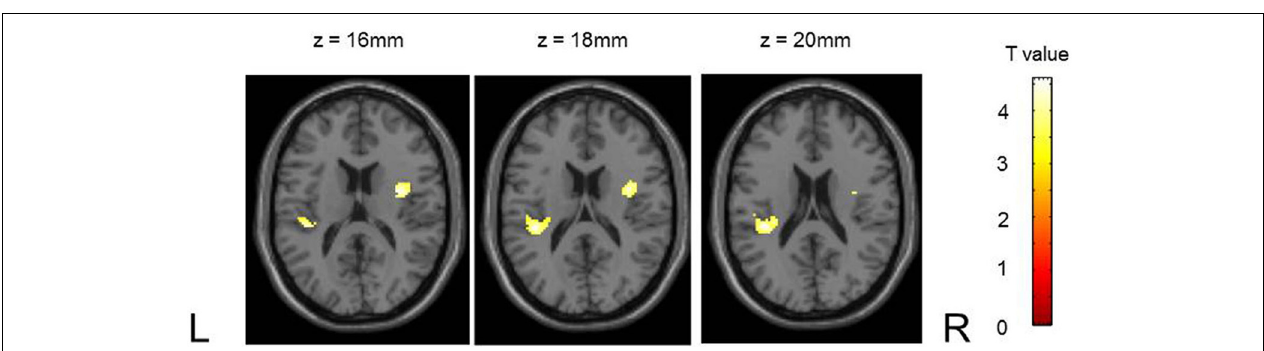
respectively ( p < 0 . 001, uncorrected). PG patients showed reduced activation compared to HC subjects. Abbreviations: PG, pathological gambling; HC, healthy control.